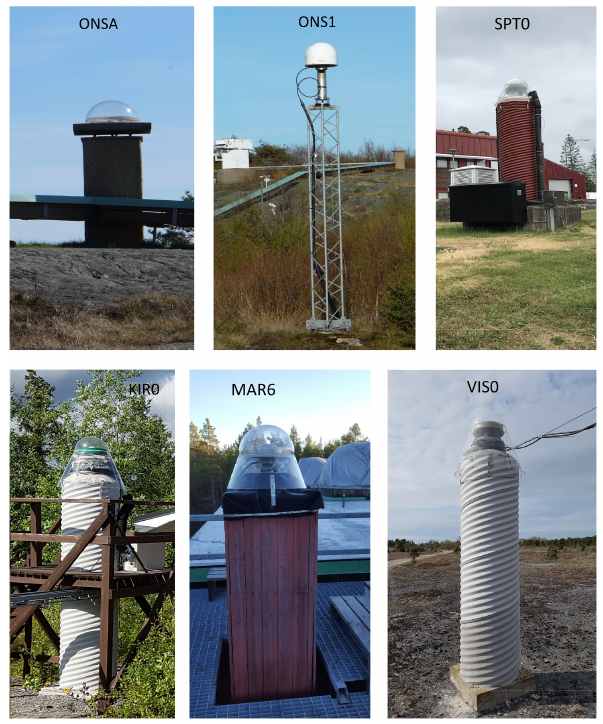
Figure 2. The six antenna installations used to acquire the GPS data. See Fig. 1 for their geographical